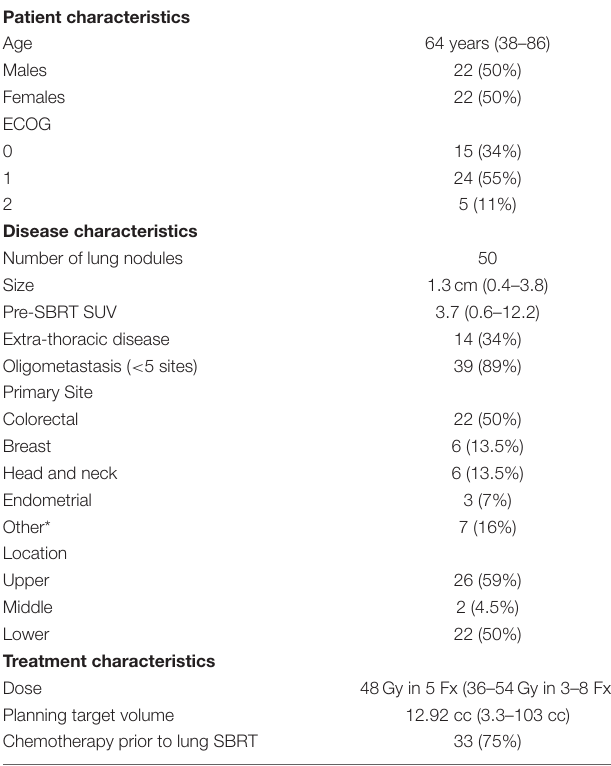
TABLE 1 | Patient, disease, and treatment-related